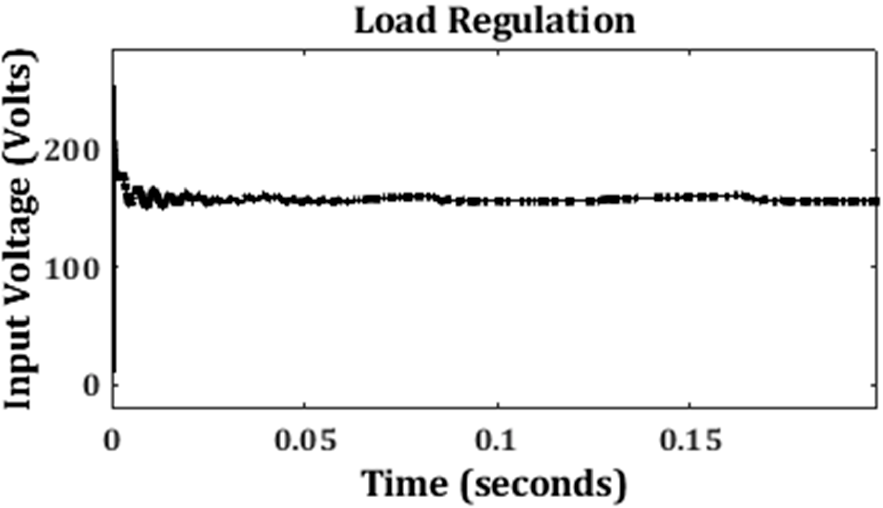
Figure 47. Input voltage from supply in (Volts) during load regulation.